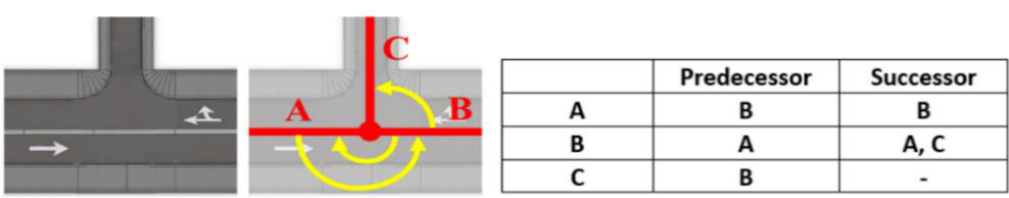
Figure 7. ( a ) Comparison of linear representations in granularity = area and granularity = lane; ( b ) Linear representations of predecessor/successor relations.